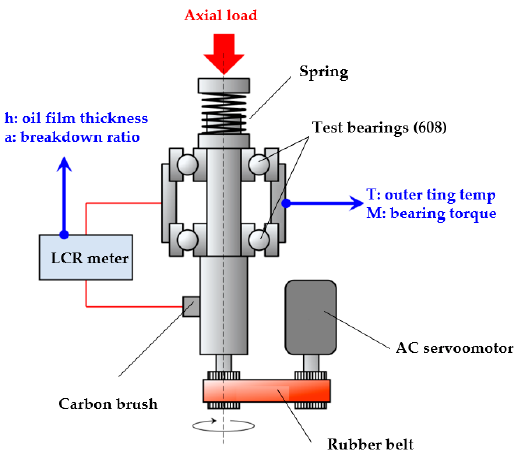
Figure 30. Bearing test rig for electrical impedance method [213].